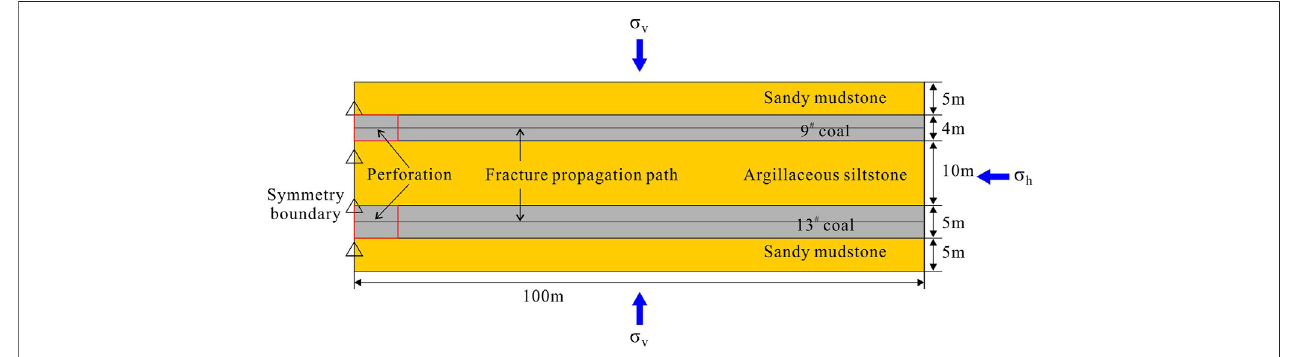
FIGURE 4 | Two-dimensional hydraulic fracturing model.